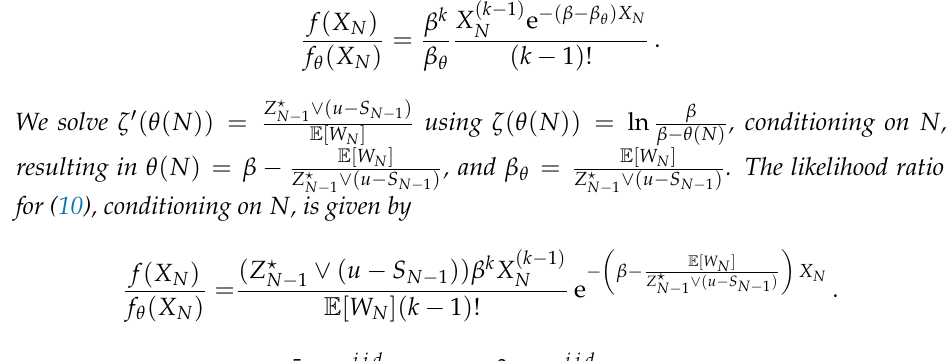
Figure 7. Proposition 1 does not provide a theoretical efficiency guarantee for this example as the log-normal distribution is neither D ∩ L nor has a Weibullian tail. From numerical example results, we can observe that estimators (cid:98) (cid:96) ConAK1 + IS + CV , (cid:98) (cid:96) ConAK2 + CV , and (cid:98) (cid:96) ConAK2 + IS + CV (importance sampling density using an exponential PDF) perform well. (cid:98) (cid:96) ConAK2 + IS + CV (importance sampling density using an exponential PDF) turns out to have slightly lower empirical logarithmic rates and higher empirical relative errors than estimators (cid:98) (cid:96) ConAK1 + IS + CV and (cid:98) (cid:96) ConAK2 + CV . The estimator (cid:98) (cid:96) ConAK2 + IS + CV (importance sampling density using an Erlang PDF) appears to fluctuate more when u becomes larger, and it has increasing empirical relative